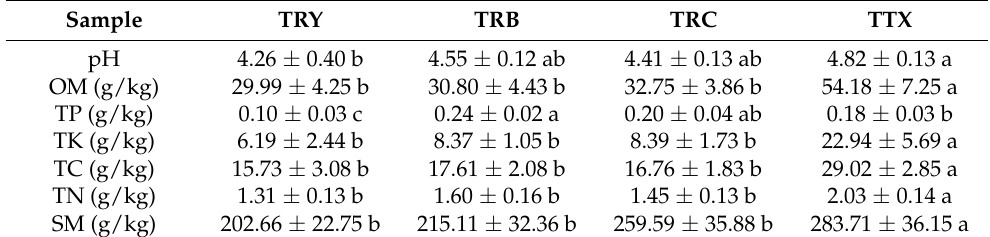
Table 1. Physical and chemical properties of the C. henryi rhizosphere soils. Sample